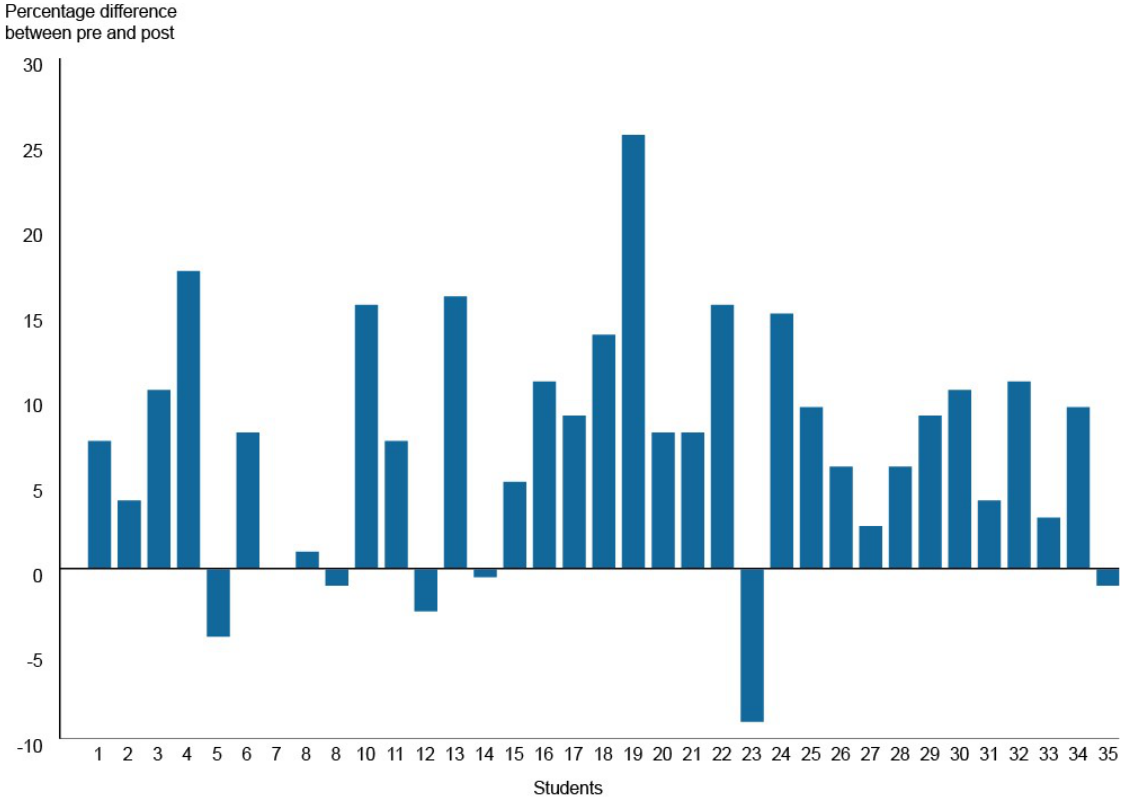
Table 1: The Percentage change recorded by students between pre and post measures of self